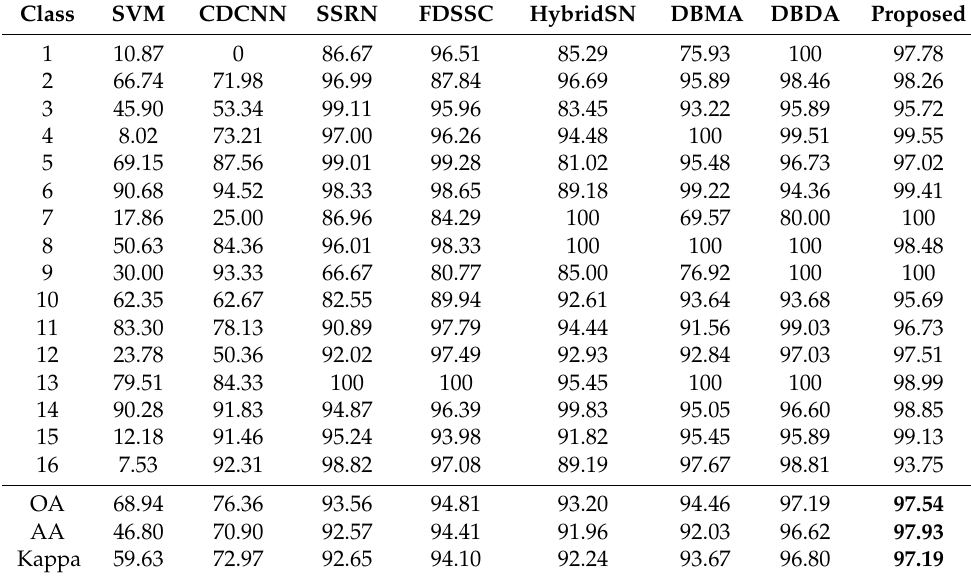
Table 8. The classification accuracy of different methods for the IP dataset.